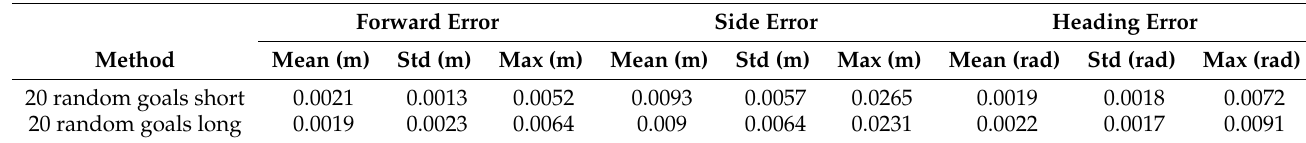
Table 2. Random goals errors.